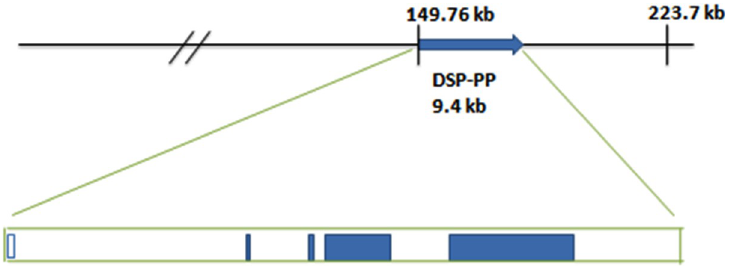
Fig 1. Diagram of mouse bacterial artificial chromosome (BAC) RP23-131C10. This 223,760 bp BAC includes the DSP-PP gene (9.4 kb) with 149.8 kb of upstream and 64.5 kb of downstream sequences. The BAC includes DSPP gene with a complete DSPP promoter.